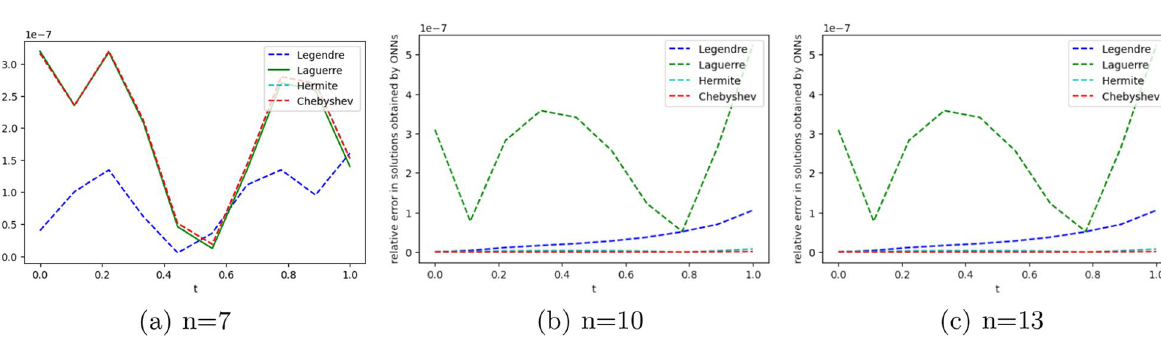
Figure 20. Error graph of z 2 ( t ) for different orthogonal neural networks with different numbers of neurons for Example